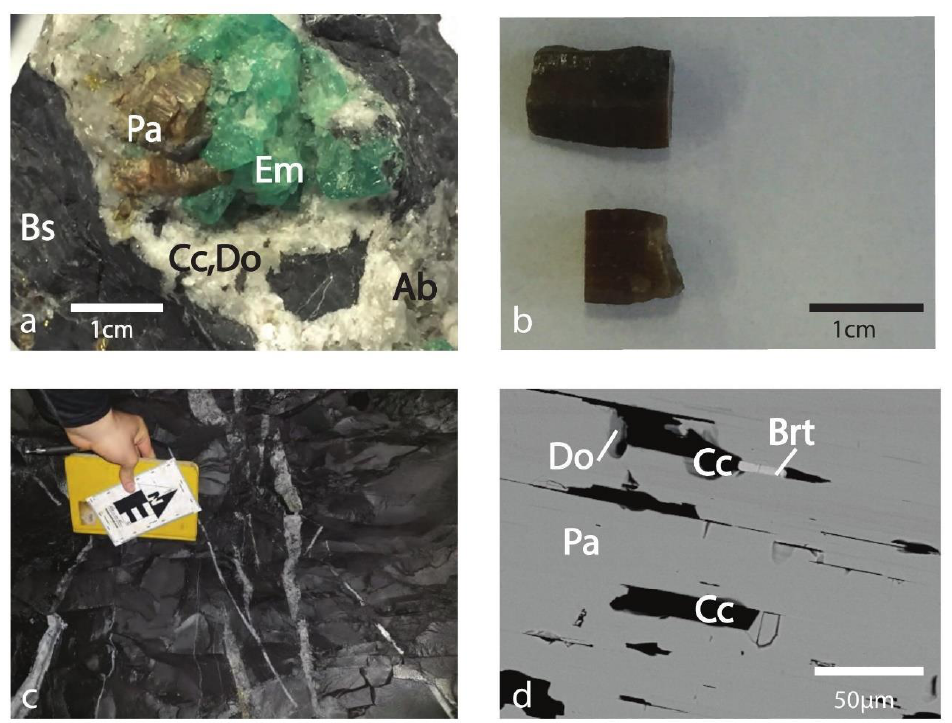
Figure 2. Parisite samples: ( a ) Parisite–emerald-bearing sample from Muzo; BS = black shale, Ab = albite, Pa = parisite, Cc = calcite, Do = dolomite, Brt = baryte. ( b ) Photo showing two of the analyzed parisite crystals from sample PA-01. ( c ) Sample locality with carbonate-rich dikes cutting the bedding planes of black shales (PA-03). ( d ) Back-scattered electron image (BSE) of inclusions in parasite (baryte (light), calcite (black) and dolomite (grey)).